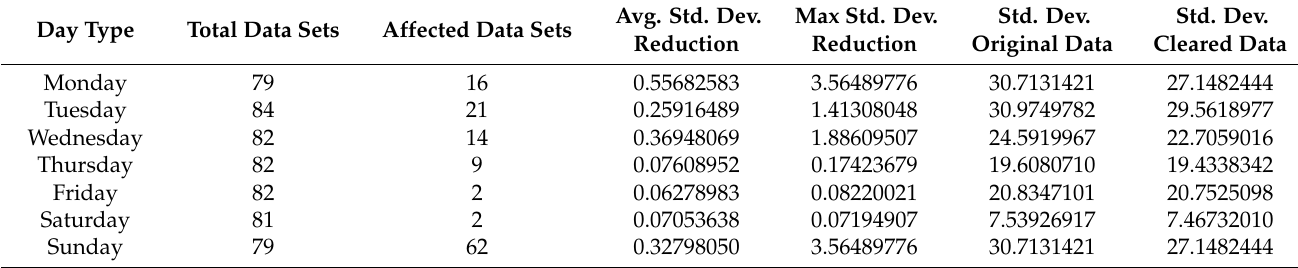
Table 11. Semester II baseline for original and cleared data